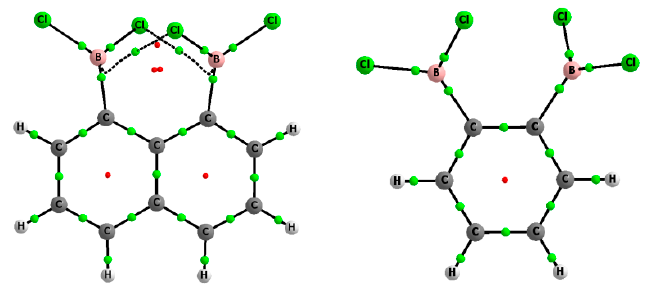
Figure 2. Molecular graphs of 1,2-bis(dichloroboryl)benzene ( right ) and 1,8-bis(dichloroboryl) naphthalene ( left ); big circles correspond to attractors (atoms), while small ones indicate bond-critical (green) and ring-critical points (red).